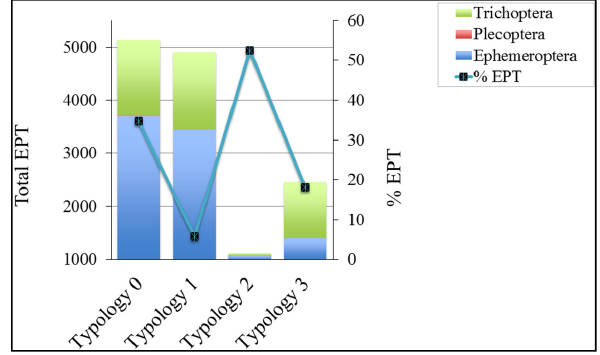
Figure 7. Total Ephemeroptera, Plecoptera, and Trichoptera (EPT) populations, and percent EPT in each typology.